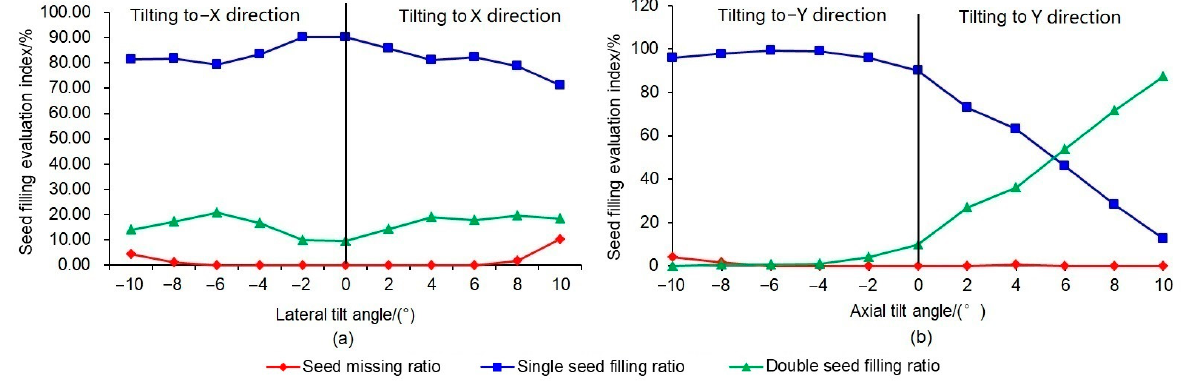
Figure 7. Effects of inclination angle on seed-filling performance: ( a ) lateral inclination angle and ( b ) axial inclination angle.